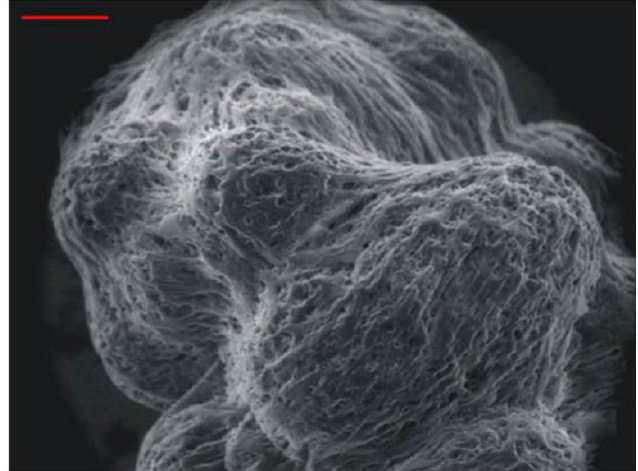
Figure 3. Scanning electron microscopy of 3-dimensional tissue-like assemblies of normal human neuronal progenitor cells maintained for 6 months in suspension. Note the indistinguishable nature of individual cells. Cells assemble around the spherical support matrix, and multiple cell-coated matrixes fuse to form tissue-like assemblies. Bar = 100 mm. Image copied with permission from PLoS Pathogens